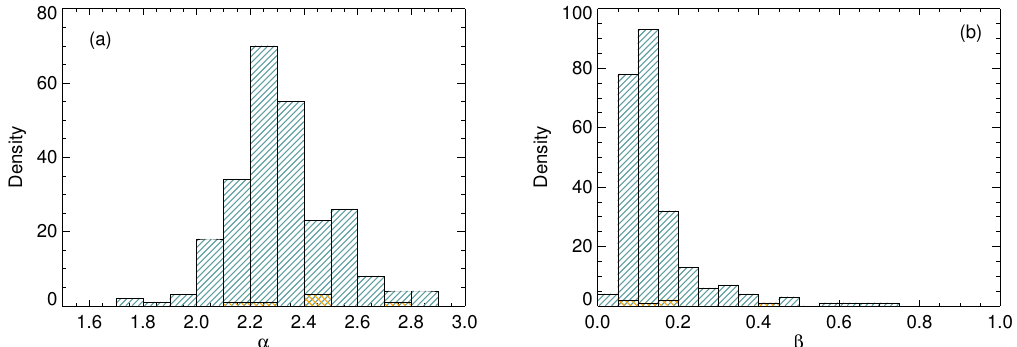
Figure 2. ( a ) Distributions of the α parameter for flat-spectrum radio quasars (blue lines) and narrow-line Seyfert 1 galaxies (orange lines). ( b ) Distributions of the β parameter for flat-spectrum radio quasars (blue lines) and narrow-line Seyfert 1 galaxies (orange